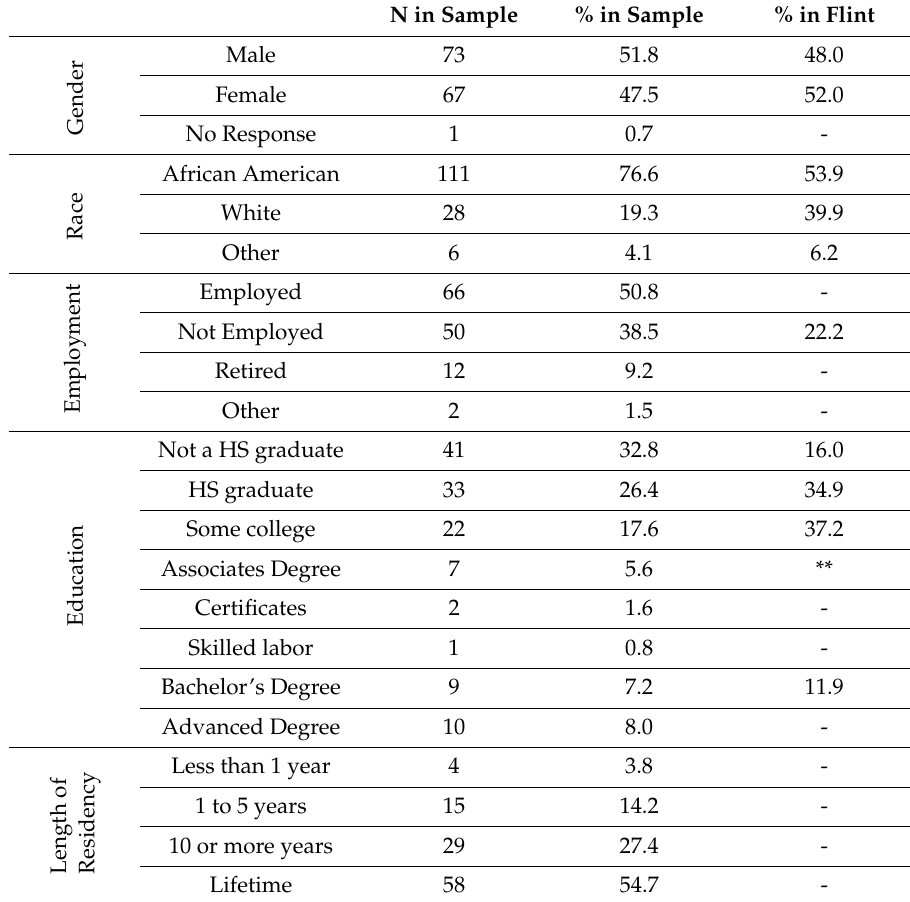
Table 1. Characteristics of participants in focus groups alongside available community characteristics for the city of Flint, Michigan. Community characteristics data are provided from the 2013–2017 American Community Survey (ACS) 5-Year